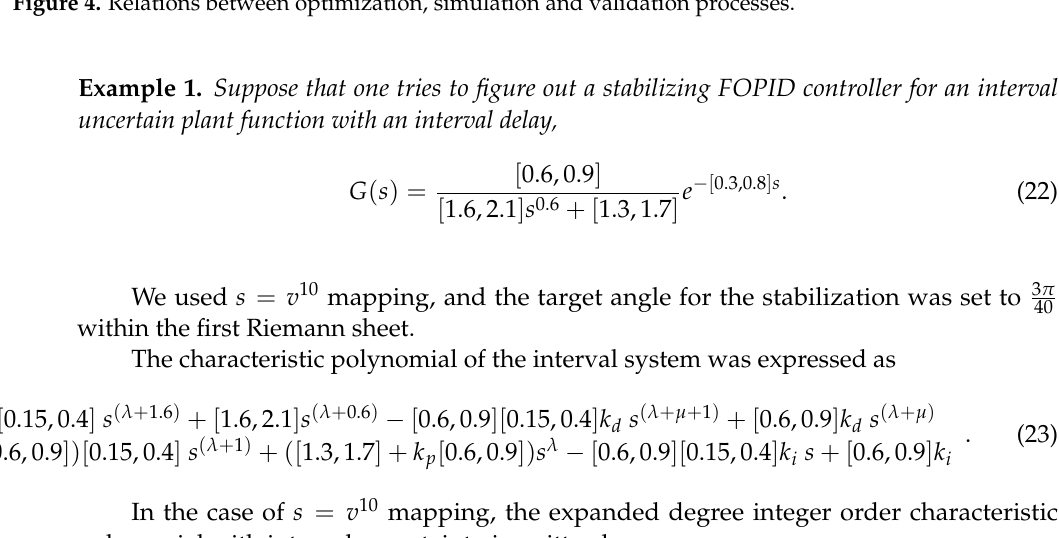
Figure 4. Relations between optimization, simulation and validation processes.